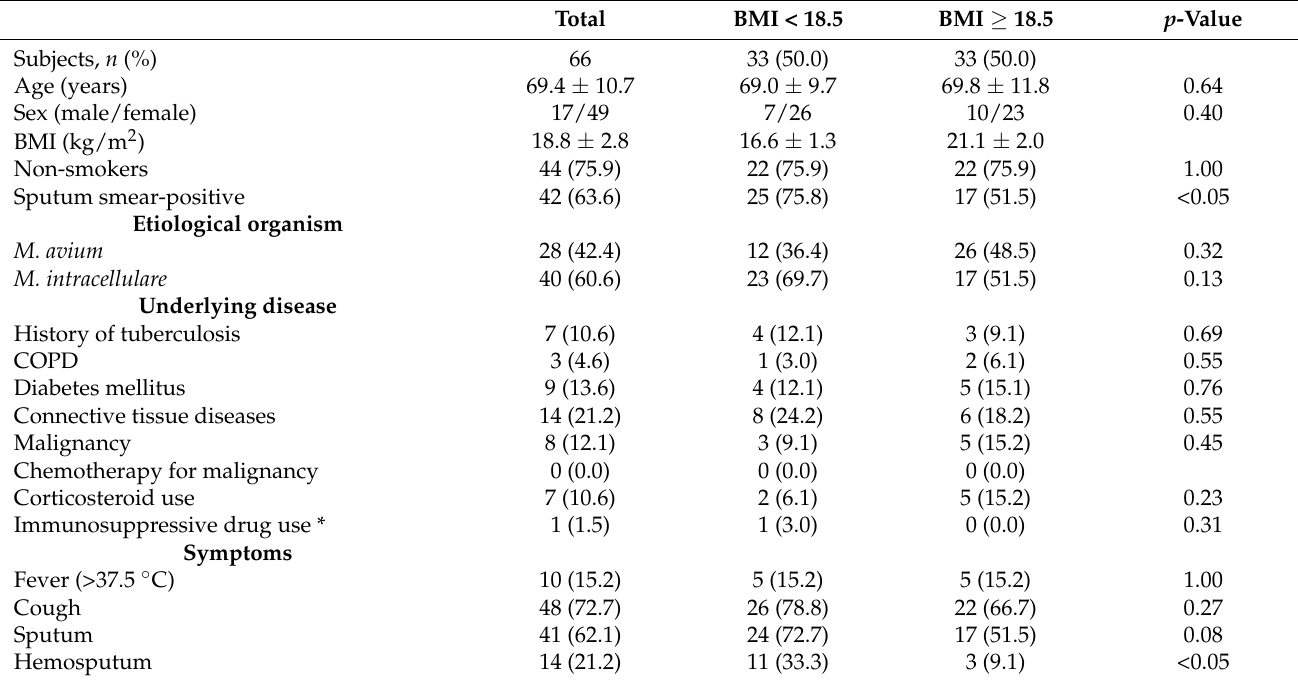
Table 3. Clinical characteristics of the MAC-PD patients with a BMI < 18.5 kg/m 2 or ≥ 18.5 kg/m 2 who received